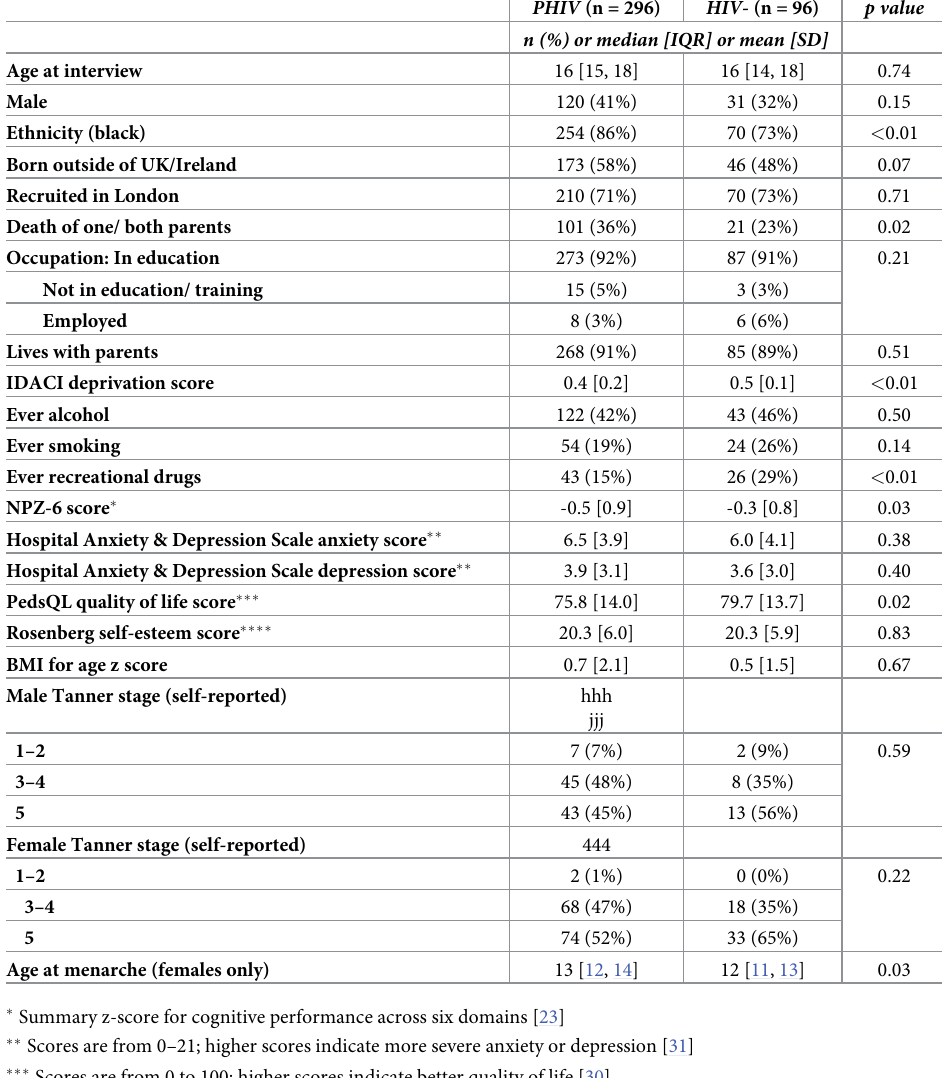
Table 1. Characteristics of PHIV and HIV-